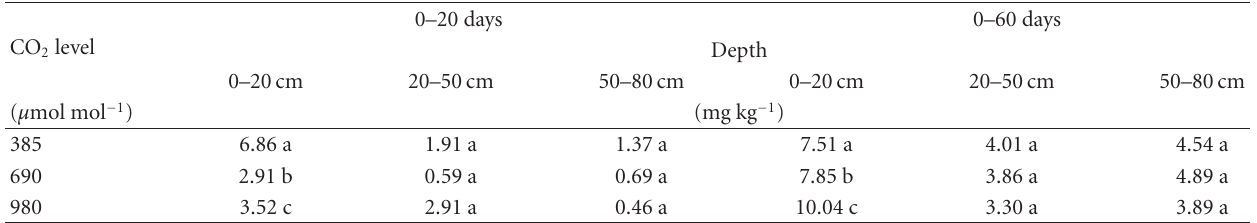
Table 1: E ff ect of atmospheric CO 2 concentration on soil N mineralization during a 60-day soil incubation at three soil depth increments †